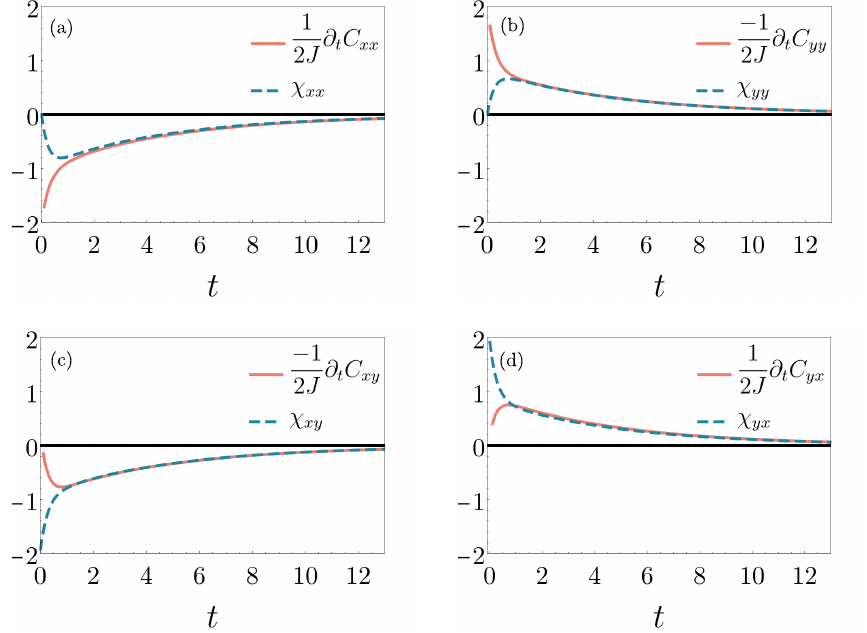
Figure 2: Numerical plots of correlation and response functions at a representa- tive critical point with J = 1, ∆ = 1, Γ = 4 and the system size N = 100. A χ ( t ) = Θ ( t ) C ( t ) / 2 T , emerges modified fluctuation-dissipation relation, O i O j O i O j ij at long times. The effective temperatures take the same value up to a sign: = − T = T = − T = J T xx x y yx y y